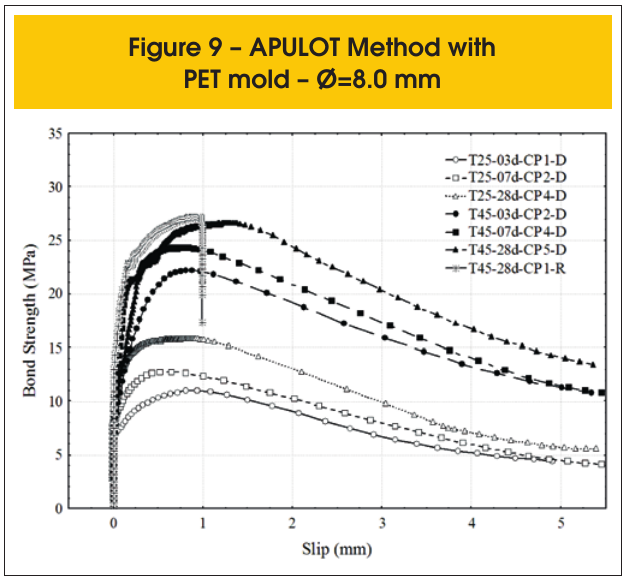
Figure 11 – APULOT Method with